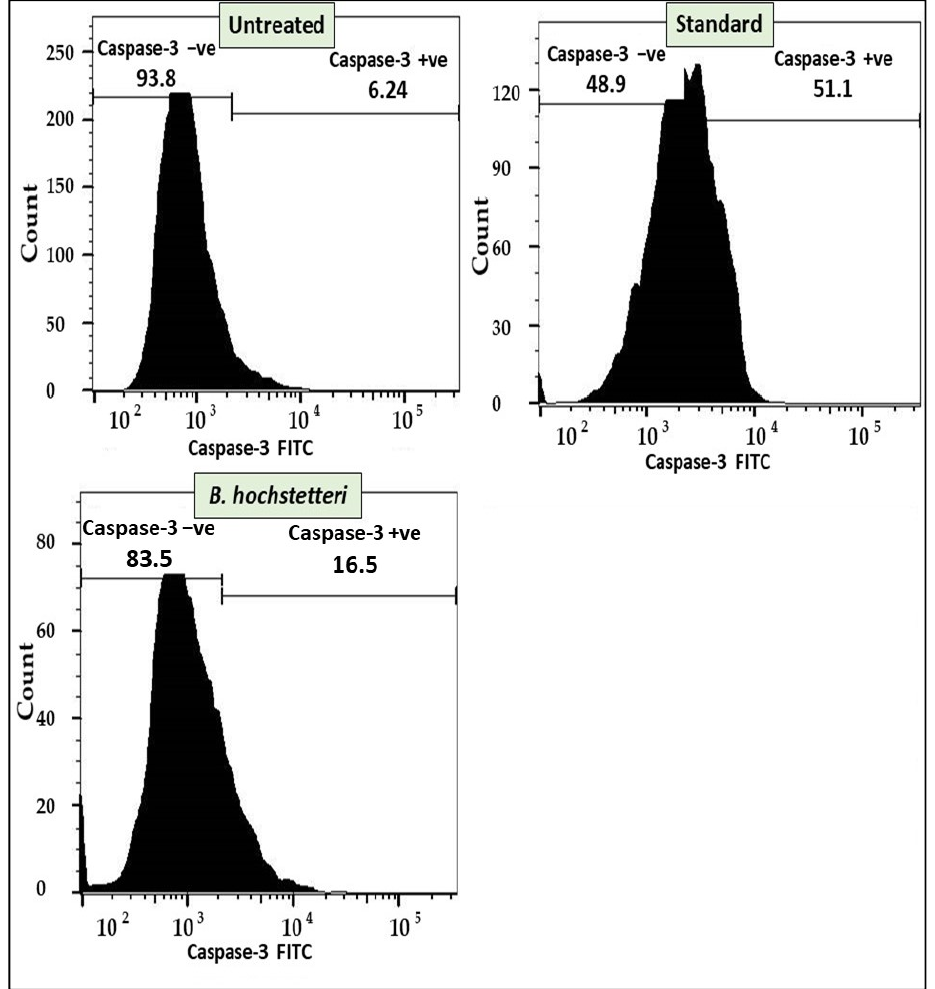
Figure 2. Apoptosis induction by the methanol extract of B. hochstetteri in lung cancer A549 cell line through the caspase-3 assay.